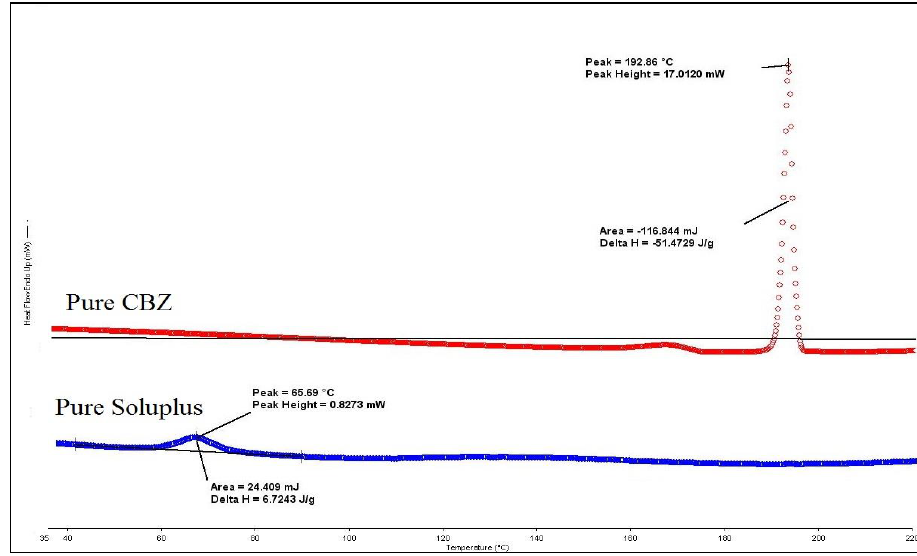
Figure 2. Differential scanning calorimetry (DSC) thermograms for pure CBZ and the pure Soluplus ® . Soluplus ® was shown a thermal peak around at 65 °C that represent its glass transition temperature. This indicated that CBZ had a narrow processing thermal range between 192 to 220 °C.